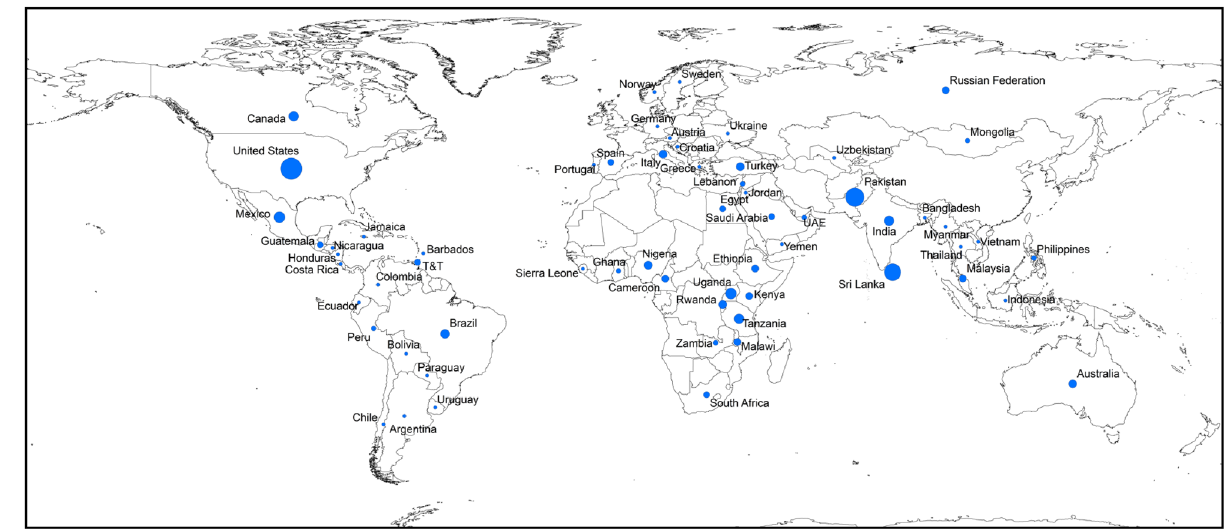
Figure 1. Survey respondents by country. Map created using ArcMap 10.7.1 (ESRI 2019. ArcGIS Desktop: Release 10.7.1. Redlands, CA: Environmental Systems Research